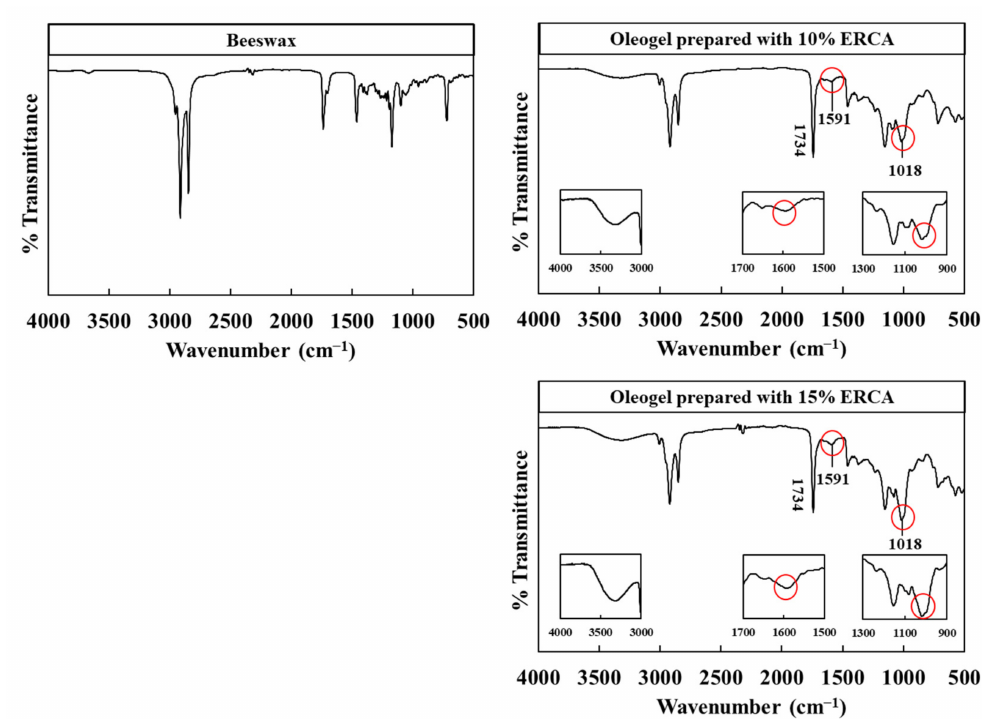
Figure 3. FT-IR spectra of soybean oil, beeswax, esterified rice flour with citric acid (ERCA), and oleogels prepared with different concentrations of ERCA (0, 5, 10, and 15%,